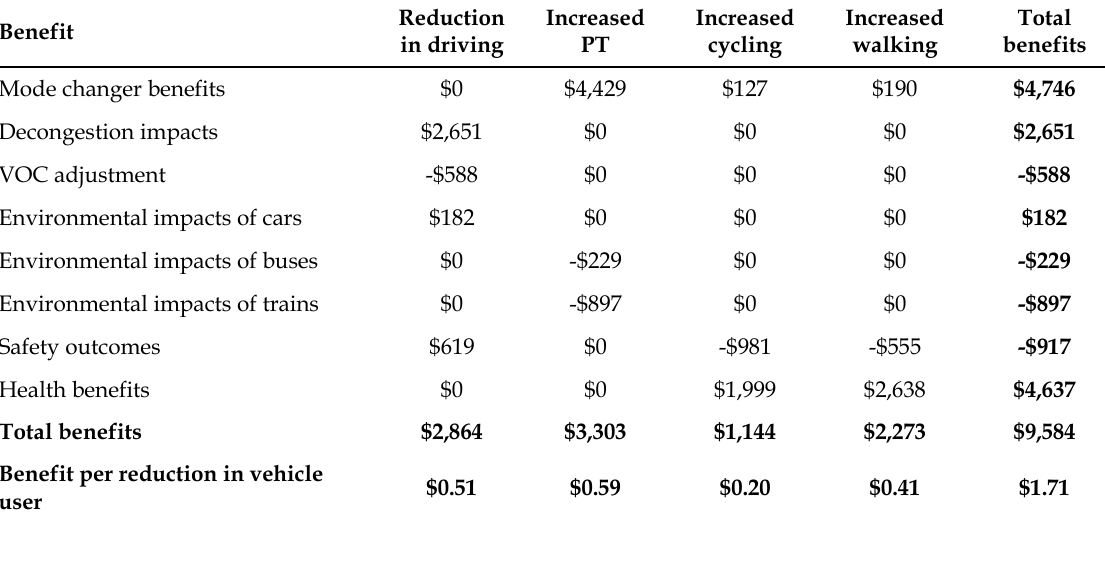
Breakdown of benefits for Option B (September 2021 dollars, per average